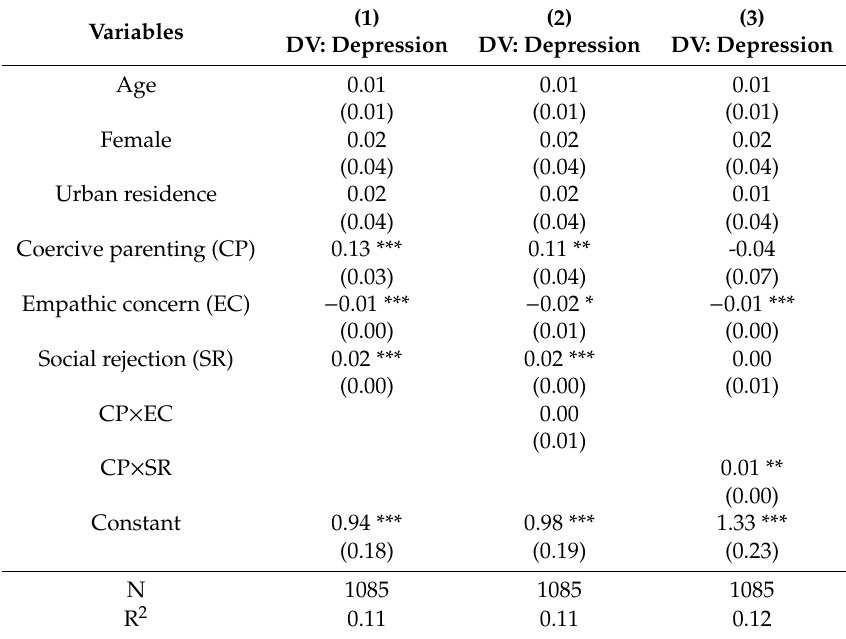
Table 5. Regression coe ffi cients of explanatory variables on